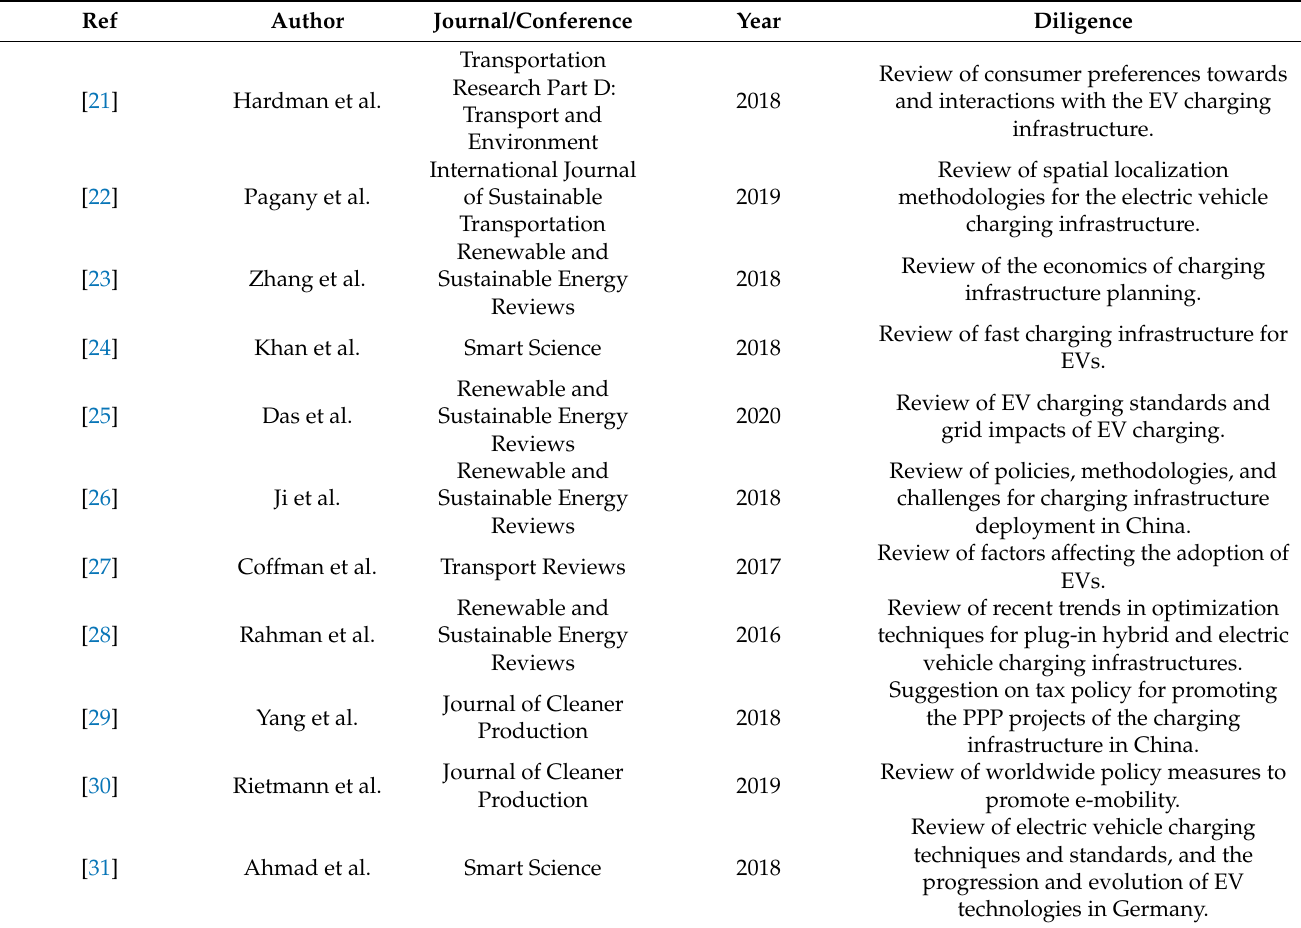
Table 1. Reviews of charging infrastructure